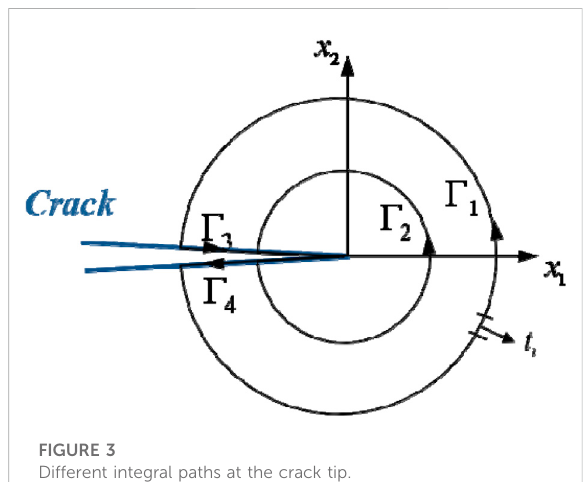
FIGURE 3 Different integral paths at the crack